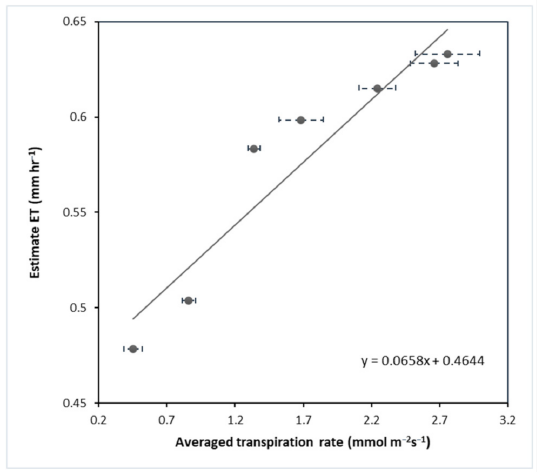
Figure 9. Comparison between the estimated ET and leaf transpiration on the sample